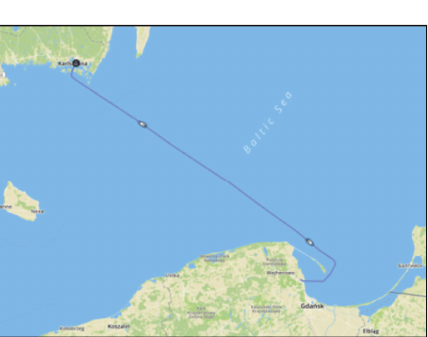
Fig. 3. MF Stena Spirit ferry [12]